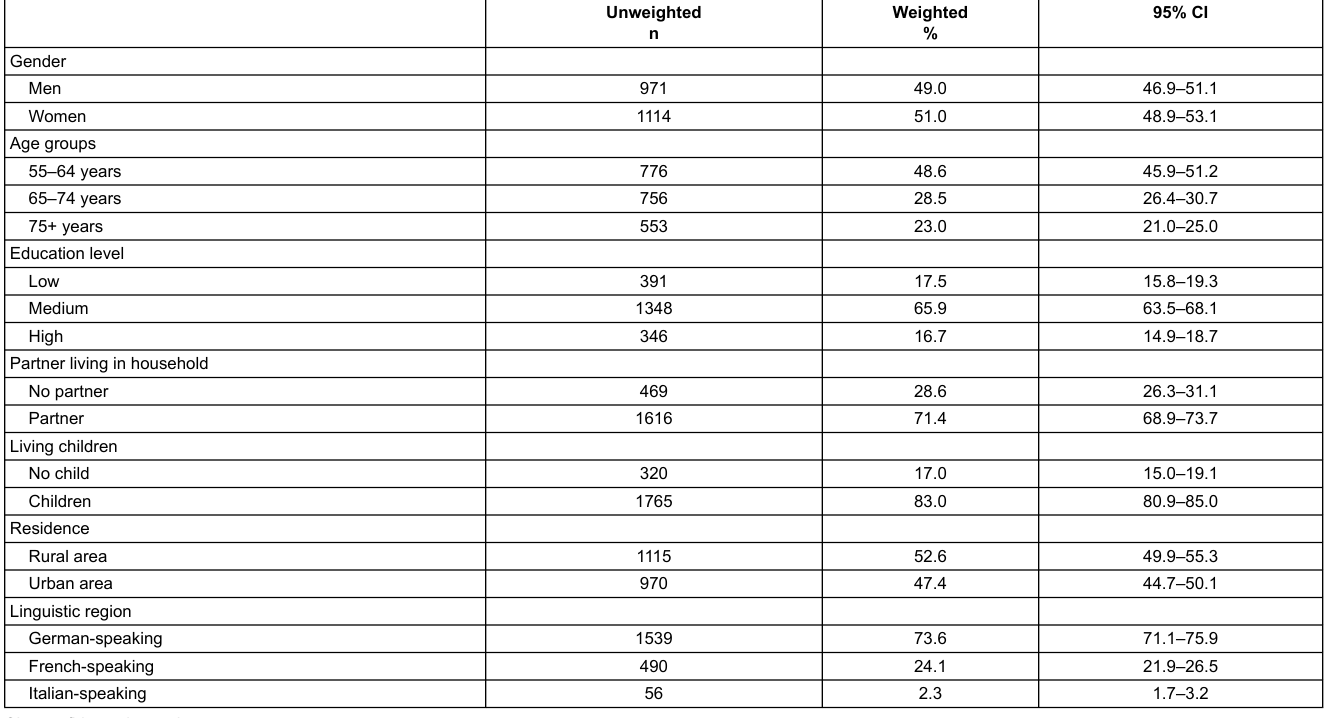
Table 1: Sociodemographic characteristics of the analytical sample, adults aged 55+ in Switzerland (n = 2085), SHARE